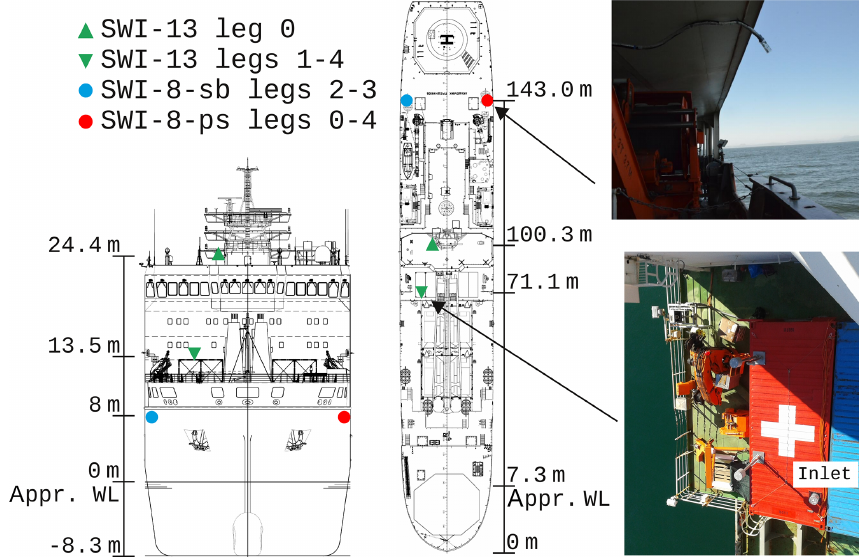
Figure 2. Inlet positions on RV Akademik Tryoshnikov (adjusted vessel plans from the Arctic and Antarctic Research Institute). Distances are given relative to the approximate water line (“Appr. WL”; metres) for the front view and relative to the front for the top view. Pictures of the mounted inlets for SWI-8-ps (top) and SWI-13 during legs 1–4 (bottom) are shown to the